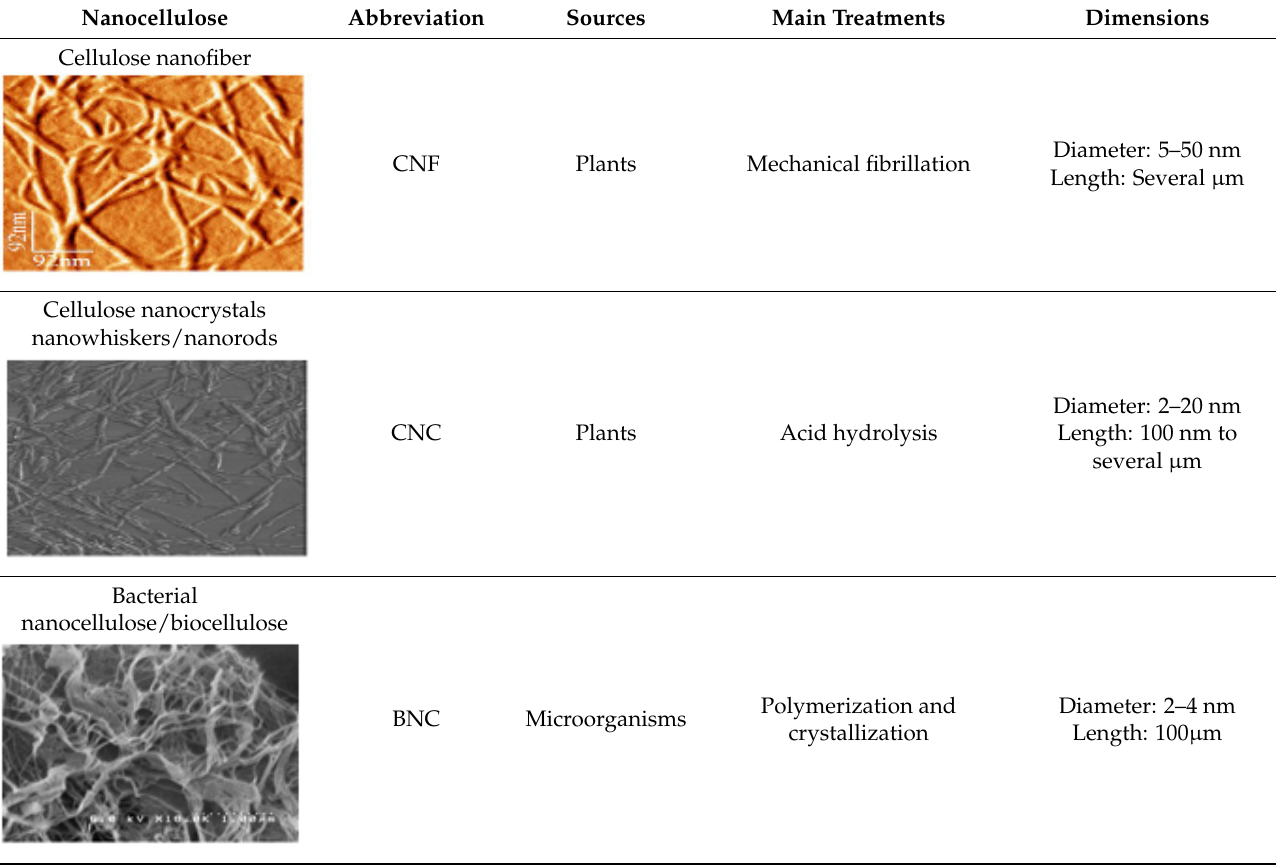
Table 5. Types of nanocellulose according to their sources, treatments and dimensions [60,81–83].